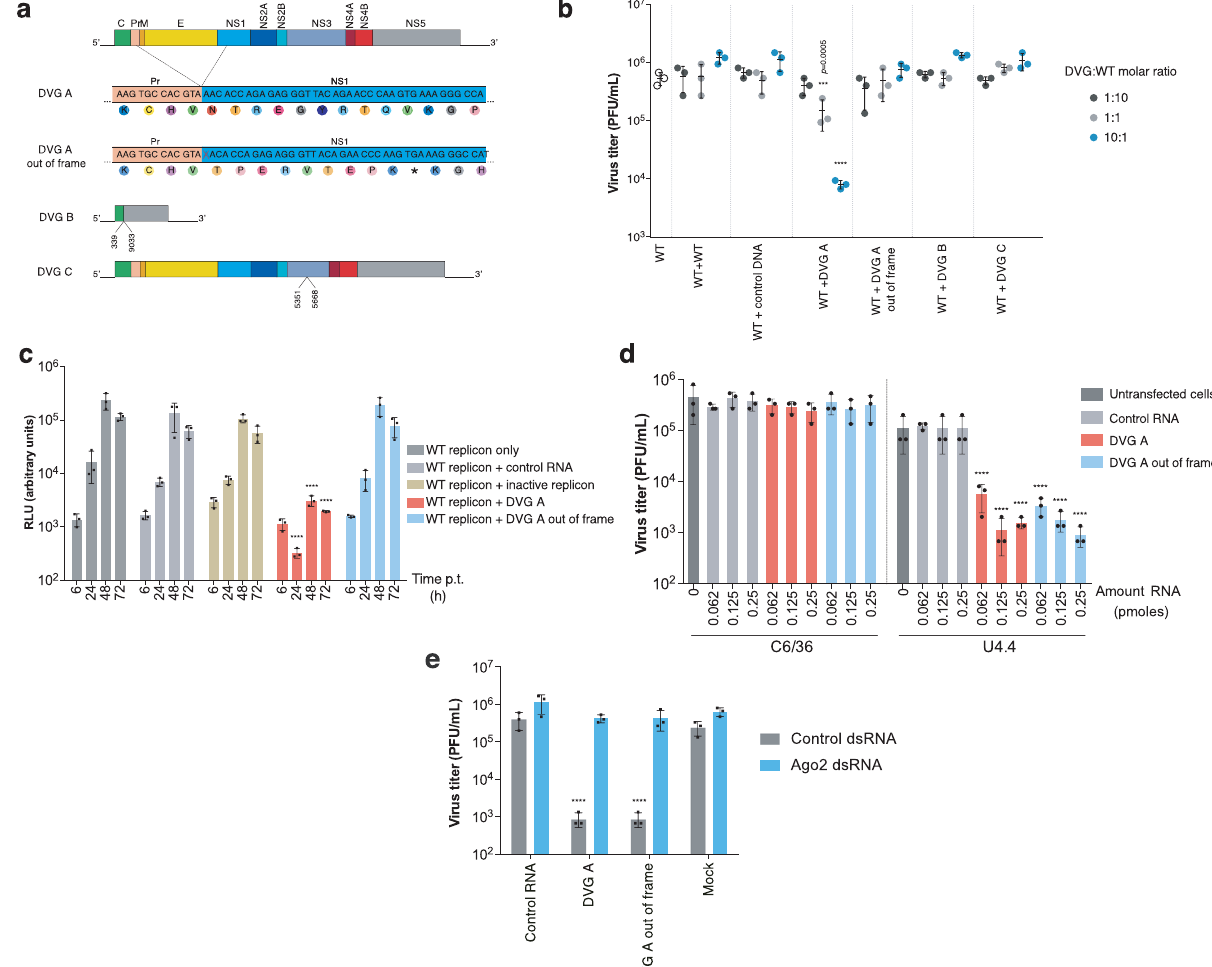
Fig. 3 DVG-A inhibits WT virus production in vertebrate and invertebrate cells. a Schematic diagram of the engineered DVGs. For DVG-A and DVG-A out-of-frame, the respective nucleotide and amino acid sequences are shown. Symbol (*) refers to a stop codon. The deleted nucleotide in DVG-A out-of- frame is crossed in red. For DVG-B and DVG-C, the nucleotides at the deletion junction are indicated. b Virus titers 72 h following co-transfection of DVG and WT-encoding plasmids in HEK-293T cells at different DVG:WT molar ratios (1:10, 1:1, and 10:1) are shown. More WT-encoding plasmid or control DNA were used as controls. **** p ≤ 0.0001 (compared to WT + WT conditions by two-way ANOVA with Dunnet ’ s multiple comparison). c Vero cells (commonly used for replicon assays) were transfected with WT replicon RNA complemented with control RNA, inactive replicon, DVG-A or DVG-A out- of-frame. Replicon activity was measured at the indicated time points p.t. **** p ≤ 0.0001 (compared to RLU values in WT replicon only-transfected cells, by two-way ANOVA with Dunnet ’ s multiple comparison). d Inhibition assays in mosquito cells. C6/36 (left) or U4.4 (right) cells were transfected with the indicated amount of control RNA, DVG-A or DVG-A out-of-frame. 18 h later, cells were infected with a MOI of 0.1 PFU/cell and virus titers measured